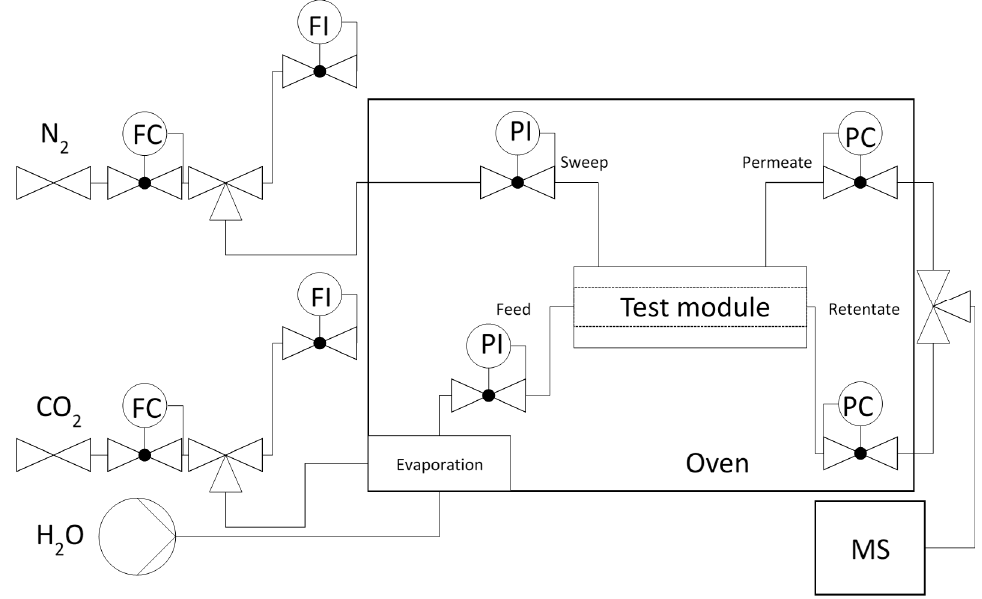
Figure 1. Schematic representation of the experimental set-up used for the separation H 2 O/CO 2 . FC, flow controller; FI, flow indicator; PI, pressure indicator; PC, pressure controller; MS, mass spectrometer.